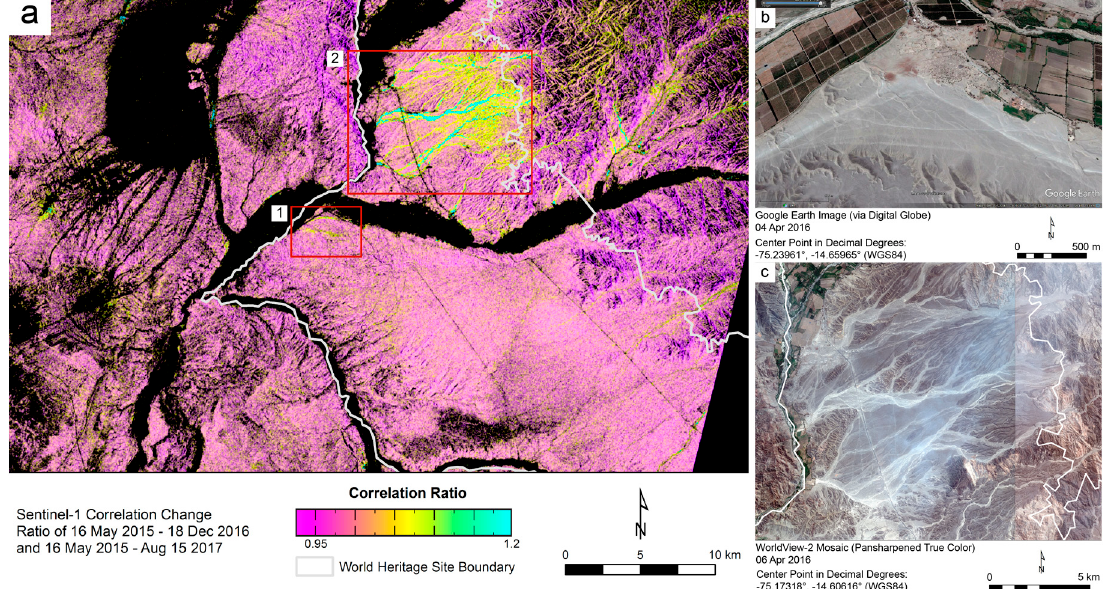
Figure 8. The correlation change image in ( a ) compares two correlation images. Red and orange areas experienced a relatively constant level of disturbance between May 2015 and August 2017. Yellow to green indicates that decorrelation during the 2016–2017 period was 5% to 20% higher than during the 2015–2016 period. Panel ( b ) is a satellite image of the area delineated and labeled 1 in ( a ); ( c ) is a satellite image of area 2. Area 1 shows two lines of atypical decorrelation: one following a road that makes a corner-like turn, and one where drivers have cut across that turn. Both the road and the shortcut are visible in ( b ). Area 2 shows evidence of flooding between December 2016 and August 2017; the apparent watercourses that this flooding appears to have followed are visible in ( c ).